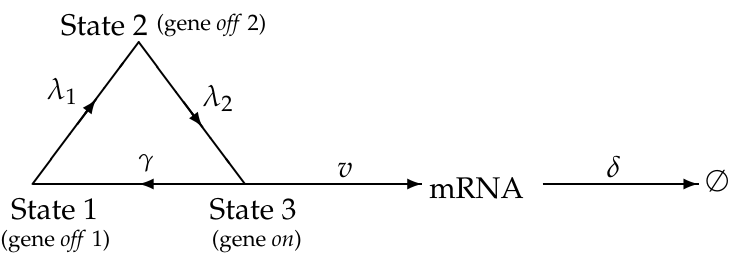
Figure 2. Three-state model of gene